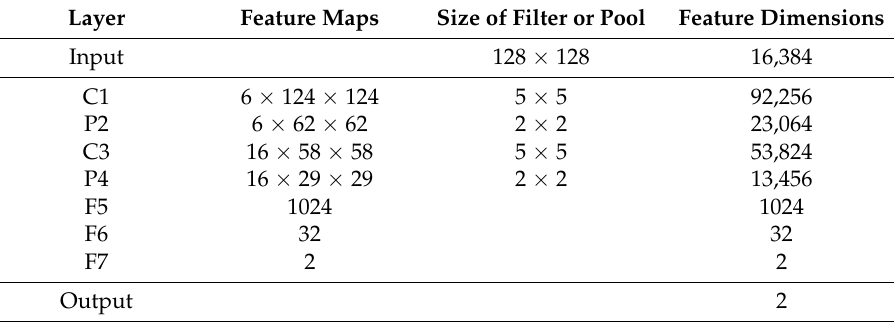
Table 3. The architecture of neural network for